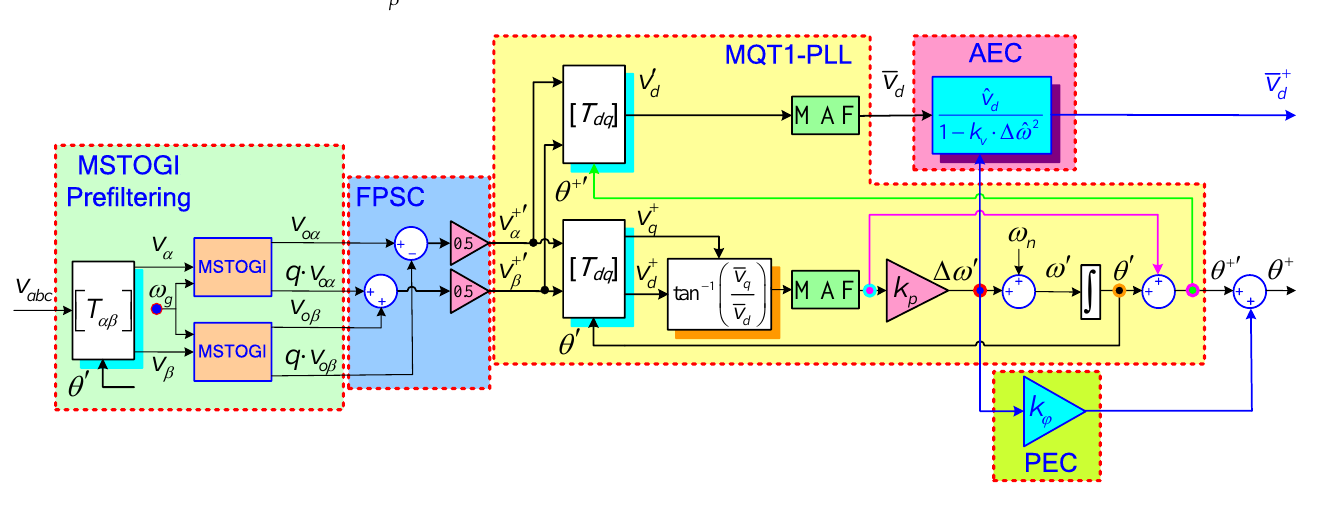
Figure 7. Pole-zero maps of MSTOGI: D ( s ) ( a ) and Q MSTOGI ( s ) ( b ).